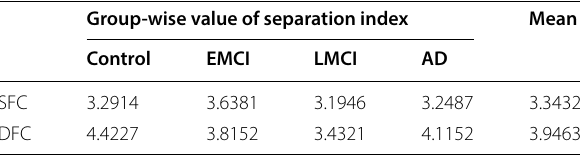
Table 4 Separation index as a measure of